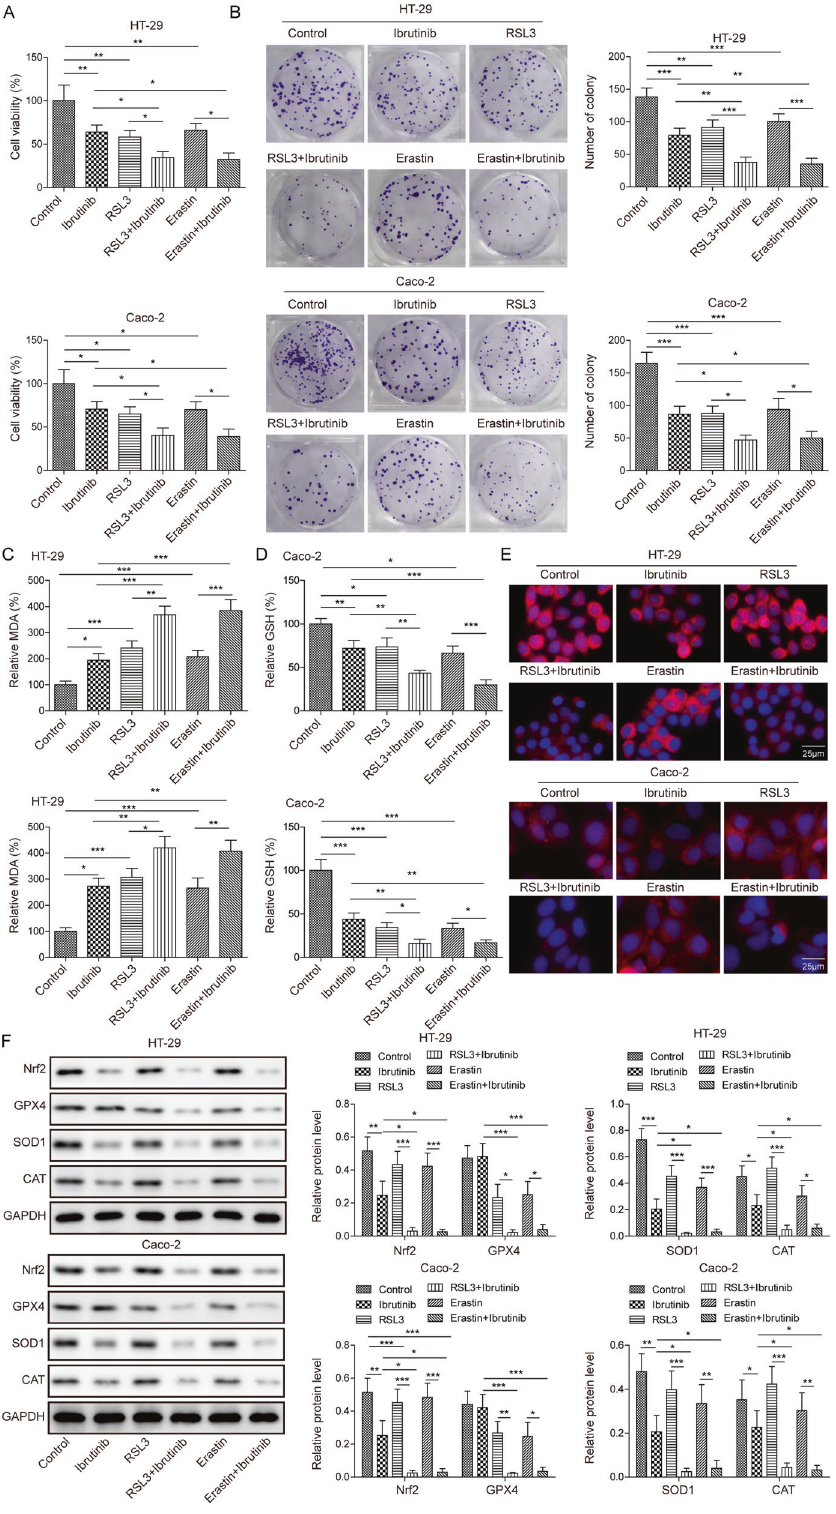
Fig. 4 Ibrutinib sensitizes CRC cells to the ferroptosis induced by RSL3 or Erastin. A The viability and B proliferation of HT-29 and Caco-2 cells that were treated with Ibrutinib, RSL3, Erastin, Ibrutinib/RSL3 or Ibrutinib/Erastin detected by the CCK-8 assay and the colony formation assay. The C MDA and D GSH levels in HT-29 and Caco-2 cells that were treated with Ibrutinib, RSL3, Erastin, Ibrutinib/RSL3, or Ibrutinib/Erastin detected by the commercial kits. E The representative immuno fl uorescent staining images of Nrf2 in HT-29 and Caco-2 cells that were treated with Ibrutinib, RSL3, Erastin, Ibrutinib/RSL3, or Ibrutinib/Erastin. Scale bar = 25 μ m. F The Nrf2, GPX4, SOD1, and CAT expressions in HT-29 and Caco-2 cells that were treated with Ibrutinib, RSL3, Erastin, Ibrutinib/RSL3, or Ibrutinib/Erastin detected by Western blot. All experiments were carried out at least three times, n = 3, * P < 0.05, ** P < 0.01 and *** P < 0.001.